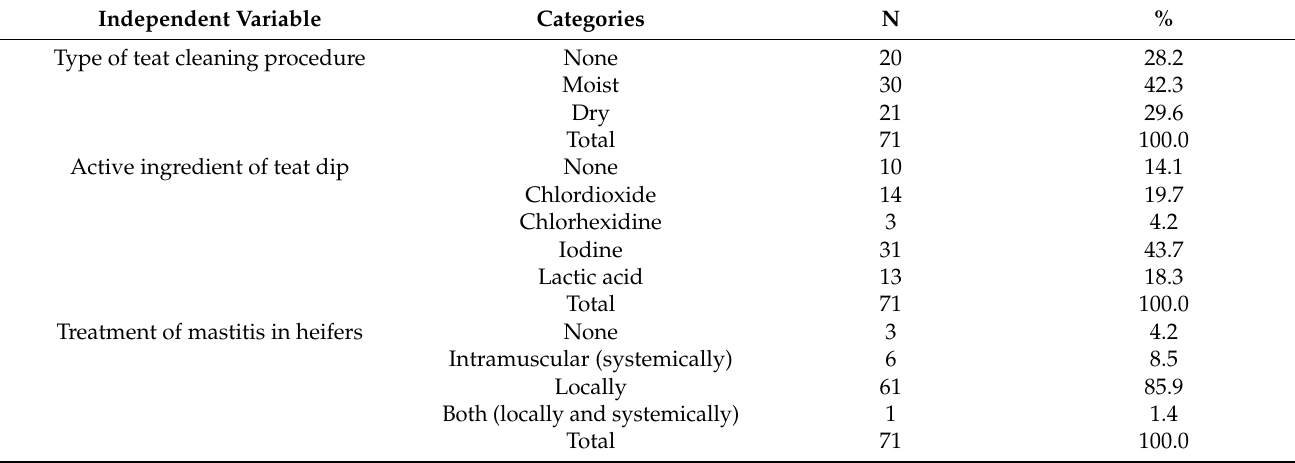
Table 5. Categorical variable